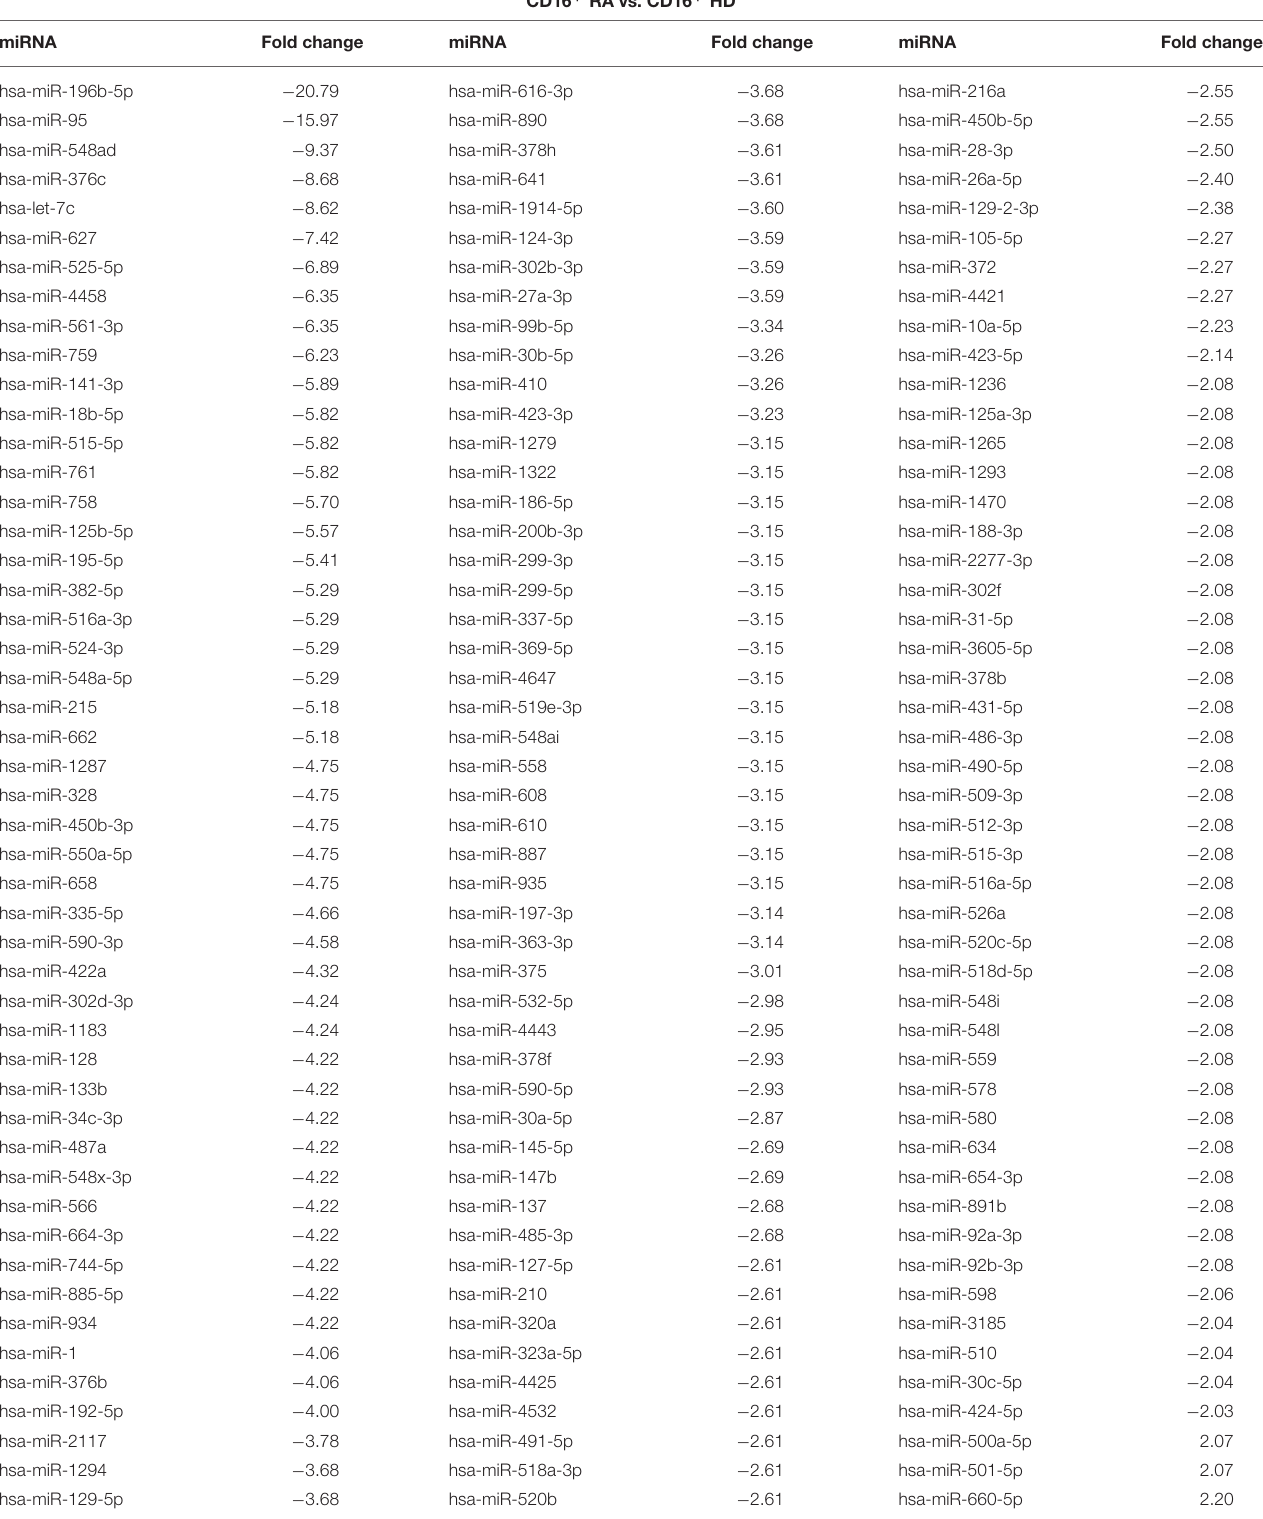
TABLE 3 | microRNA expression profile of CD16 + monocytes from Rheumatoid Arthritis patients vs. CD16 + monocytes from healthy donors. CD16 + RA vs. CD16 +